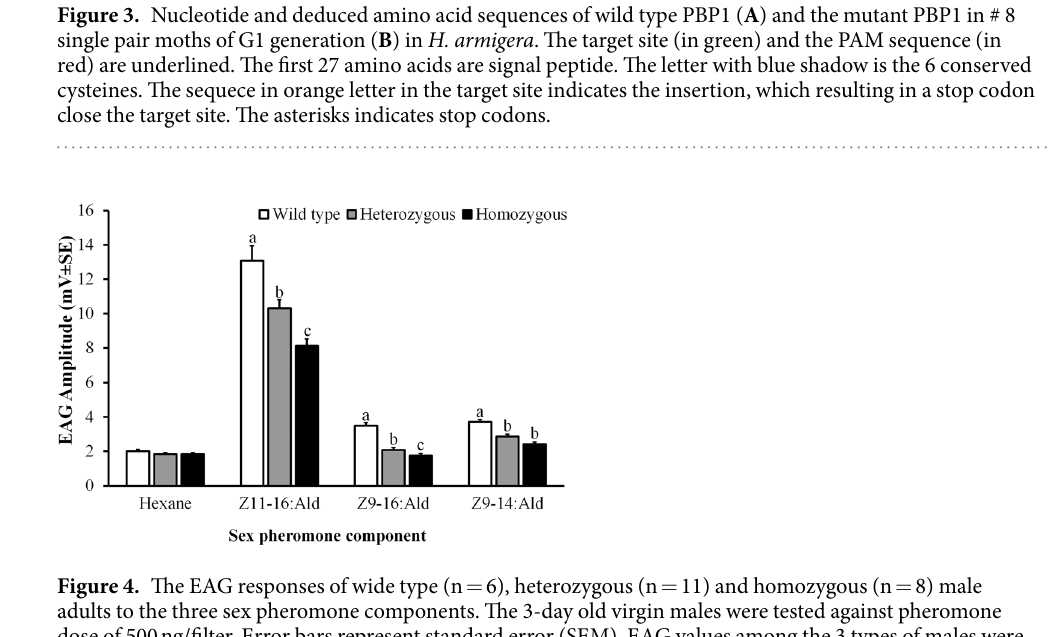
with the no injection wild type males, both homozygous and heterozygous mutants showed significantly lower EAG responses to all the 3 sex pheromone components (Z11-16:Ald, Z9-16:Ald and Z9-14:Ald) at the tested dosage (500 ng). In addition, homozygous mutants showed significantly lower EAG responses than heterozygous mutants to the first two pheromone components (Fig. 4). Off target effect of the mutagenesis by CRISPR/Cas9 system. Without the available genome data of H. armigera , a transcriptomic data was used to search for the potential off target sequences using CasOT tool were no multiple peak observed in the sequence chromatograms (Fig. S2), suggesting that the sgRNA used in our study was target sequence specific.